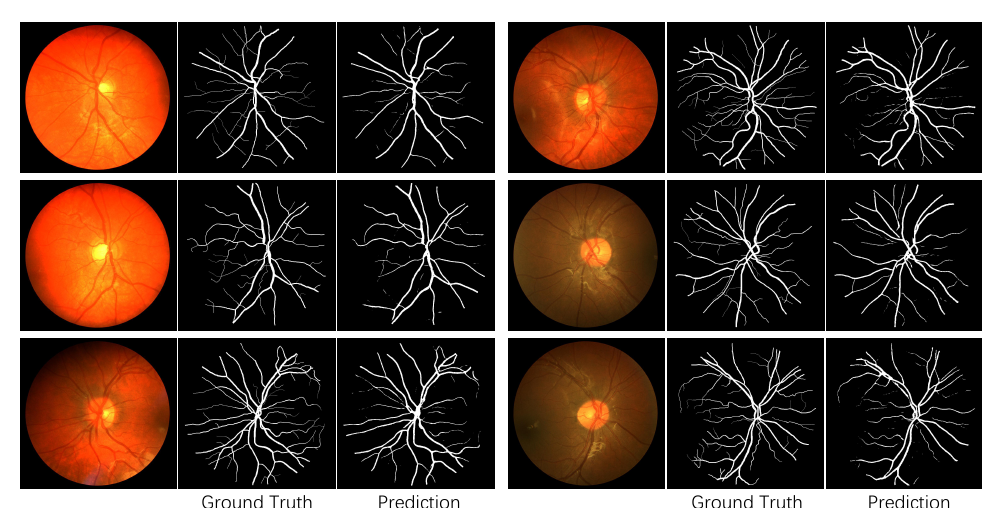
Ground Truth Prediction Figure 4. The segmentation example of the proposed method on the CHASEDB1 dataset.